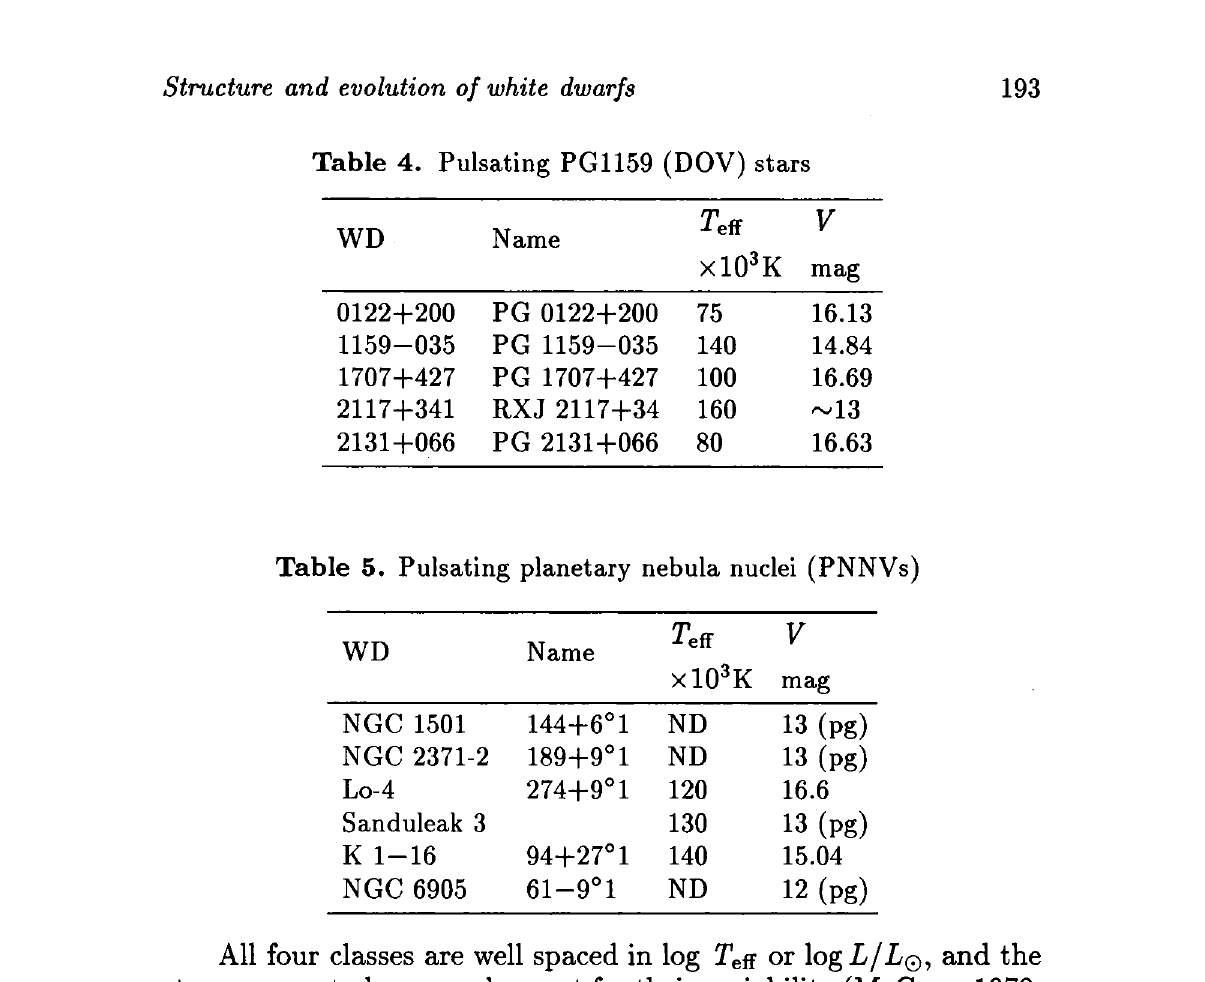
Table 4. Pulsating PG1159 (DOV) stars